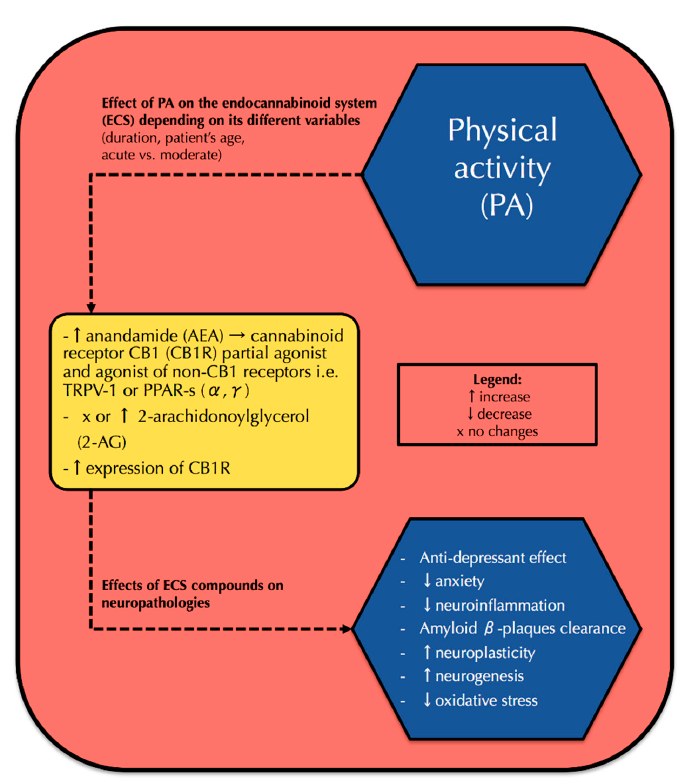
Figure 1. The effect of physical activity on the endocannabinoid system components and, Figure 1. The e ff ect of physical activity on the endocannabinoid system components and, subsequently, its possible impact on the attenuation of neuropathologies. PA: physical activity, ECS: endocannabinoid system, AEA: anandamide, CB1R: cannabinoid receptor type 1, TRPV-1: transient receptor potential vanilloid type 1, PPAR: peroxisome proliferator-activated receptors α , 2-AG: